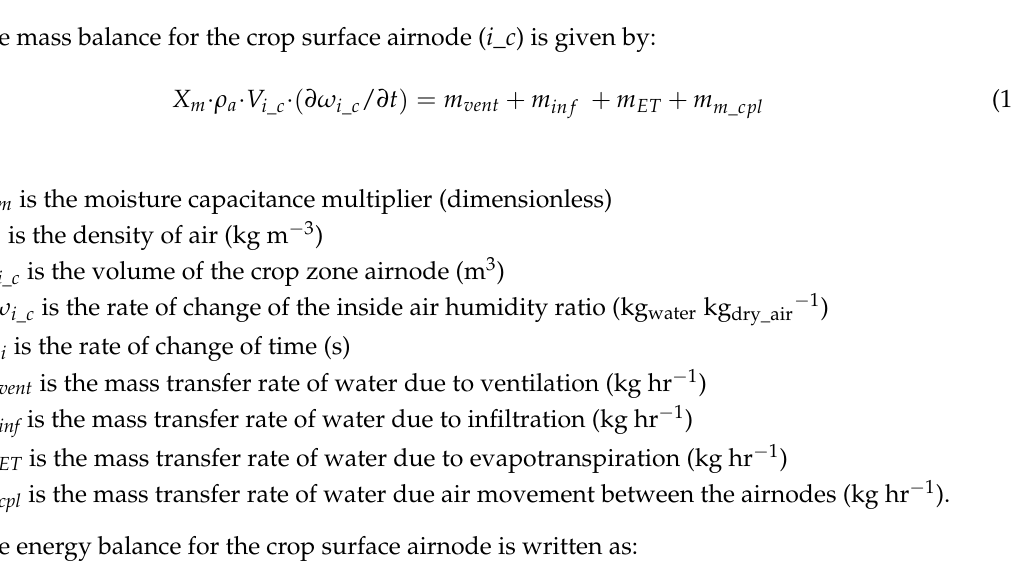
Figure 6. Schematic showing the mass and energy fluxes considered in the three airnode greenhouse model.